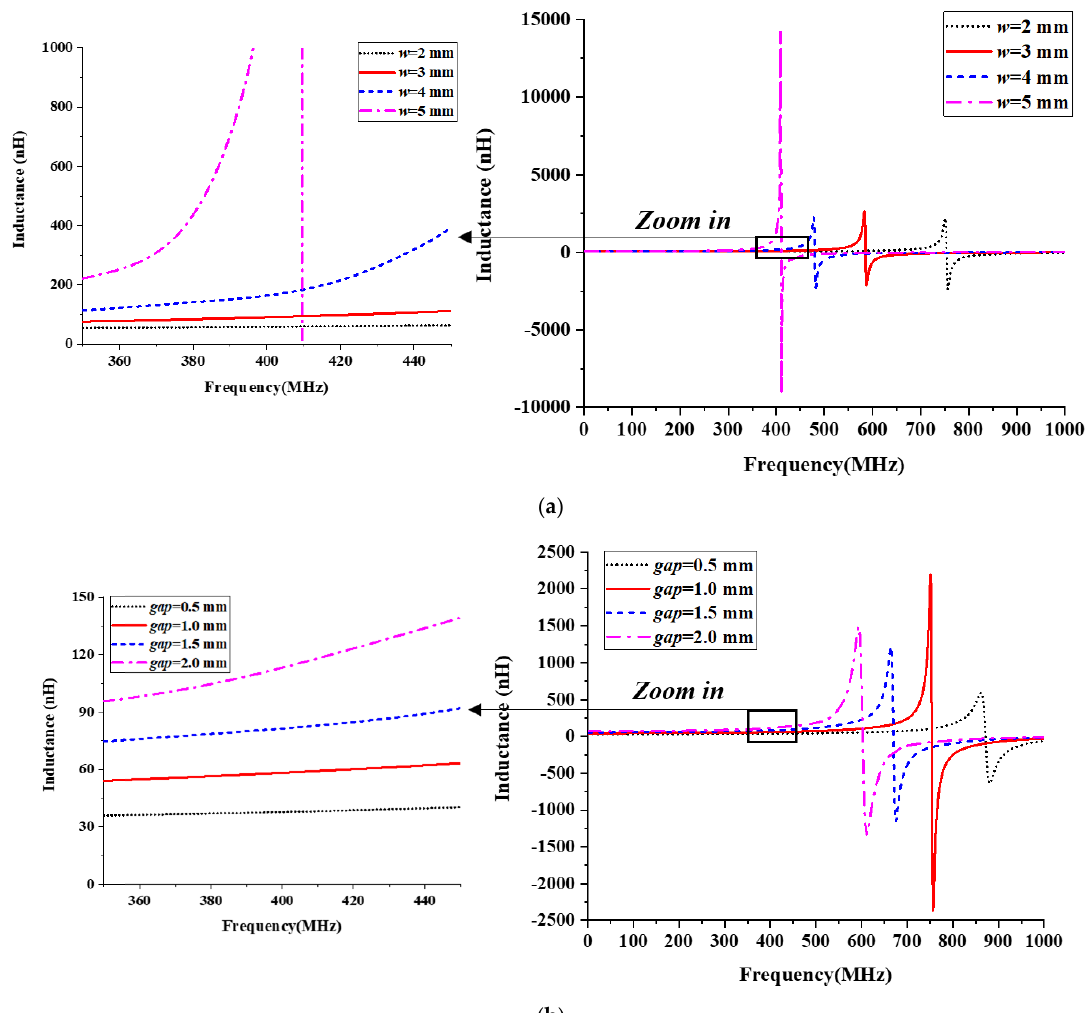
Figure 5. Simulated inductance of four-turn split-ring loops with ( a ) swept parameter w (with the gap g = 1 mm); ( b ) swept parameter g (with the width w = 2 mm).